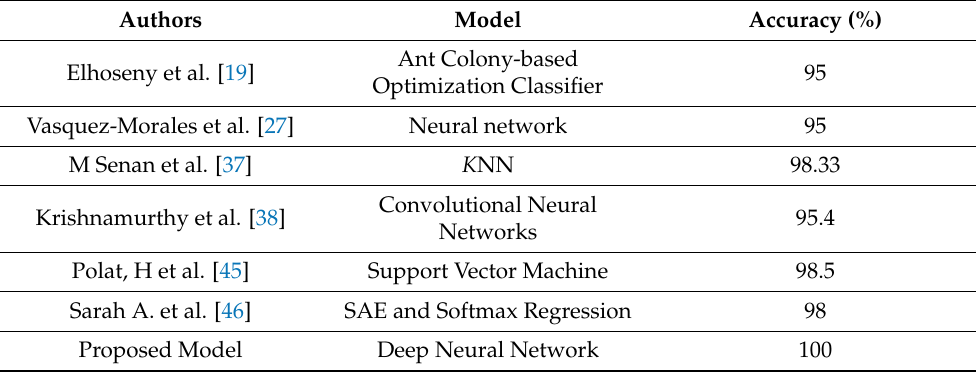
Table 6. Comparative analysis of the proposed model with existing models from the literature on the UCI data